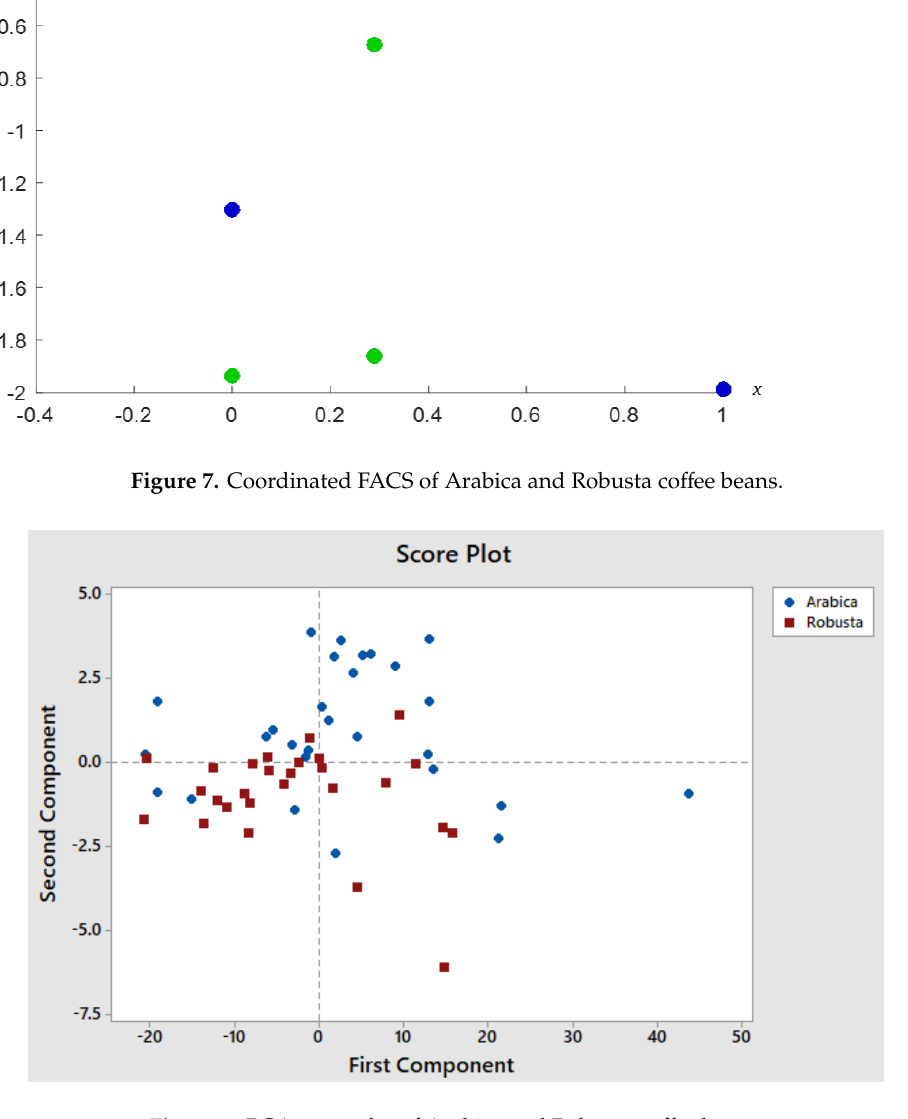
Figure 9. FACS graph of meat spectrum at 1600–1000 cm −1 region.